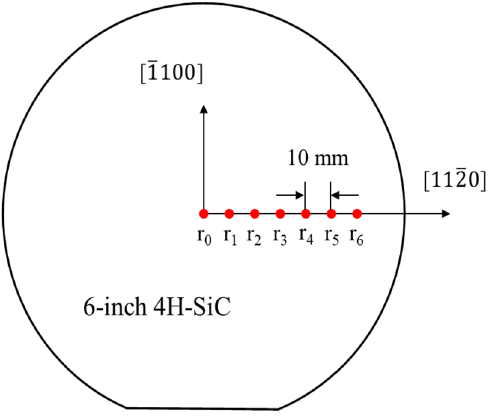
Table 1. RMS measurement results of 6-inch 4H-SiC wafers as a function of Si/H ratio.